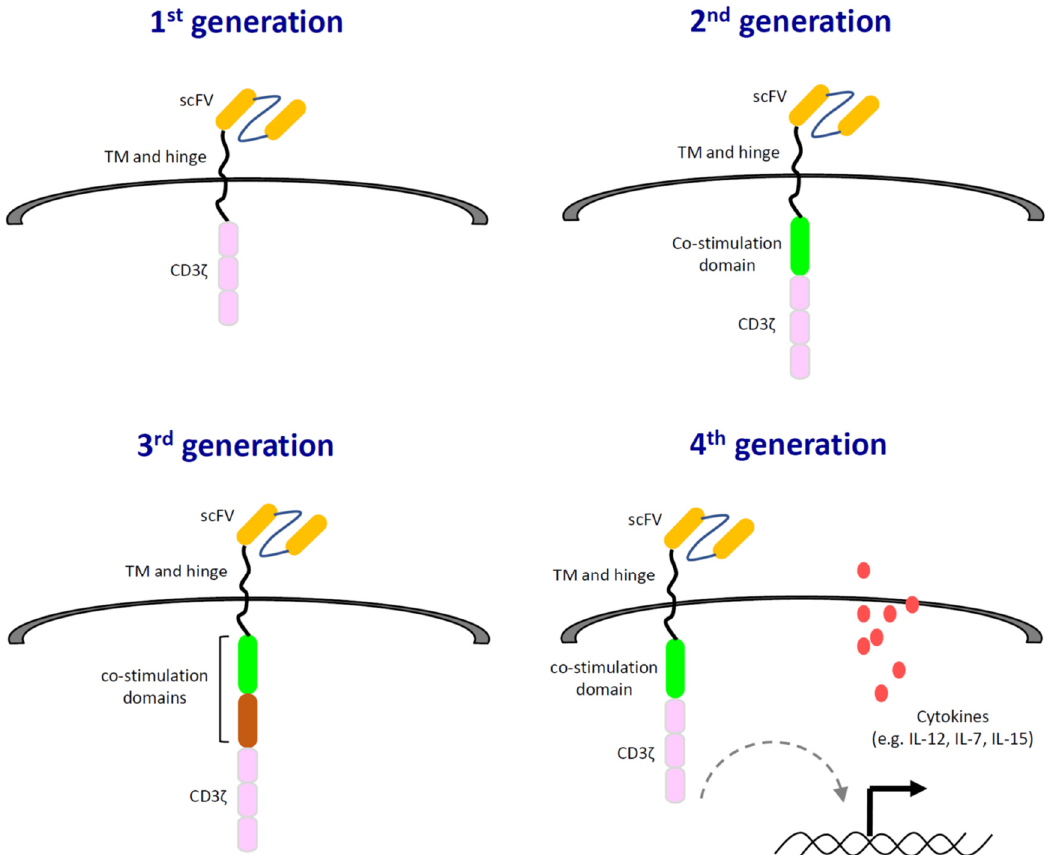
Figure 1. Schematic overview of the main CAR generation formats. The 1st generation CAR is made of an antibody-derived single-chain Fv (scFv), a hinge and transmembrane (TM) region, and a CD3 ζ signaling domain. 2nd or 3rd generations contain one or two intracellular co-stimulatory domains linked to CD3 ζ , respectively. Costimulatory domain(s) can include CD28, 4-1BB, OX40, and ICOS. The 4th generation resembles the 2nd CAR generation, except it has integrated genetic modifications to induce the production of certain cytokines enabling modulation of immune responses in response to CAR activation.